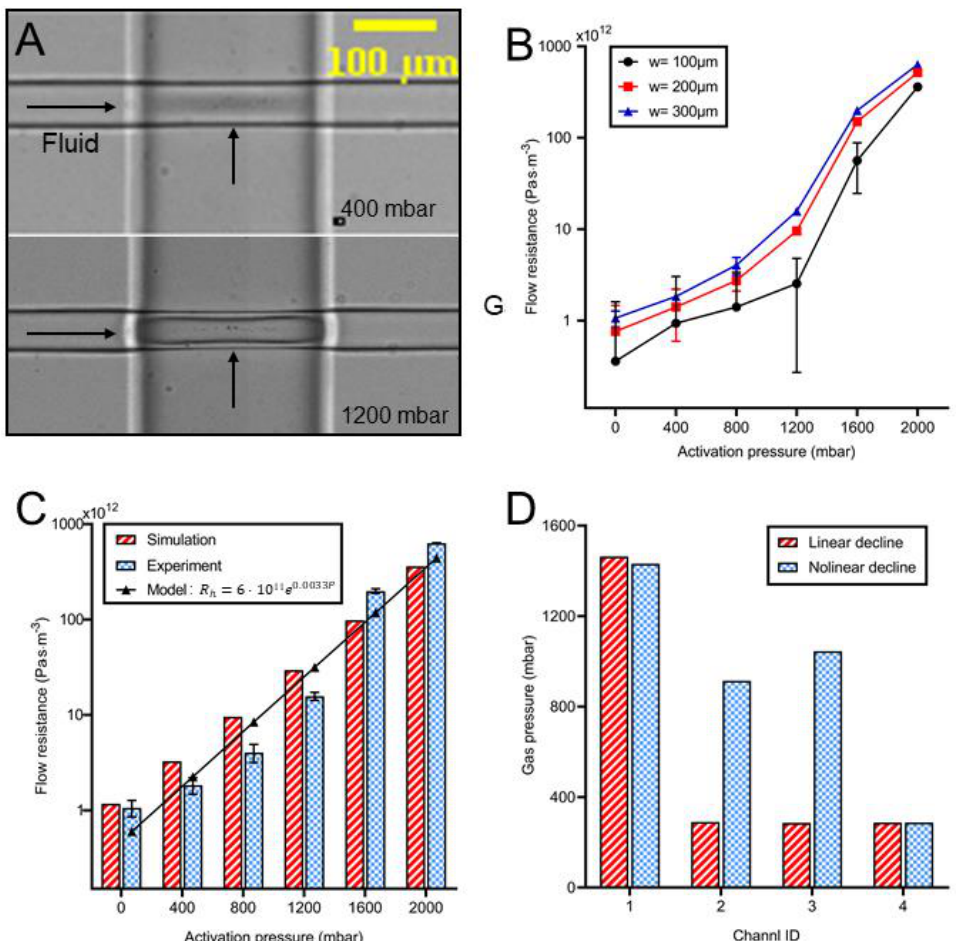
Figure 4. Measuring flow resistance in microvalves at various pressures. ( A ) The images of the deflecting membrane (20 μm thick) in a 200 μm long valve. ( B ) The flow resistance in the valve regions at various pressures. ( C ) The flow resistance (of a 300 μm valve) acquired either from experiment or simulation. The black line was a model describing the relationship between activation pressure and resistance (goodness: 0.86). ( D ) Activation pressures required to generate linear and nonlinear declining concentration profiles in four parallel channels (see Section 3.1).